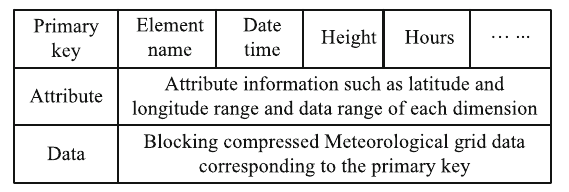
table structure, and effectively improves the throughput performance of data analysis.